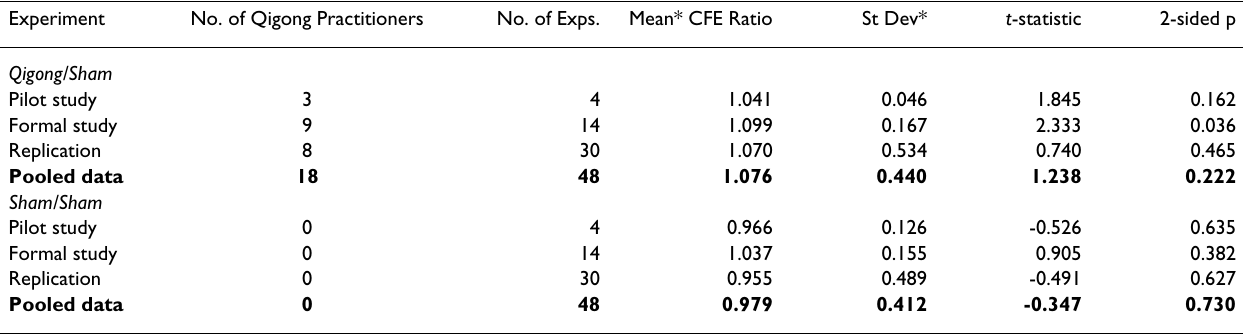
Table 1: Summary of study results Experiment